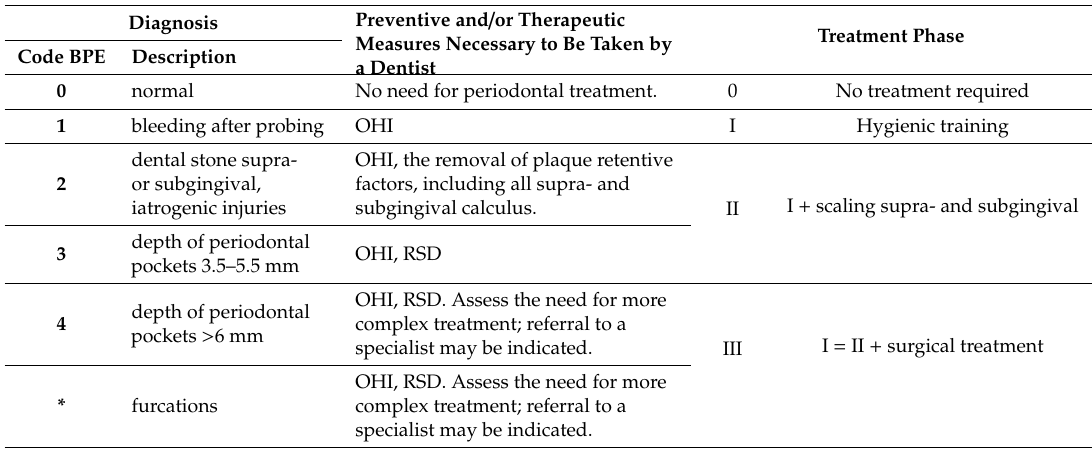
Table 7. Preventive and / or therapeutic procedures depending on the results of activities carried out in the hygienization phase of periodontal disease treatment and the BPE score